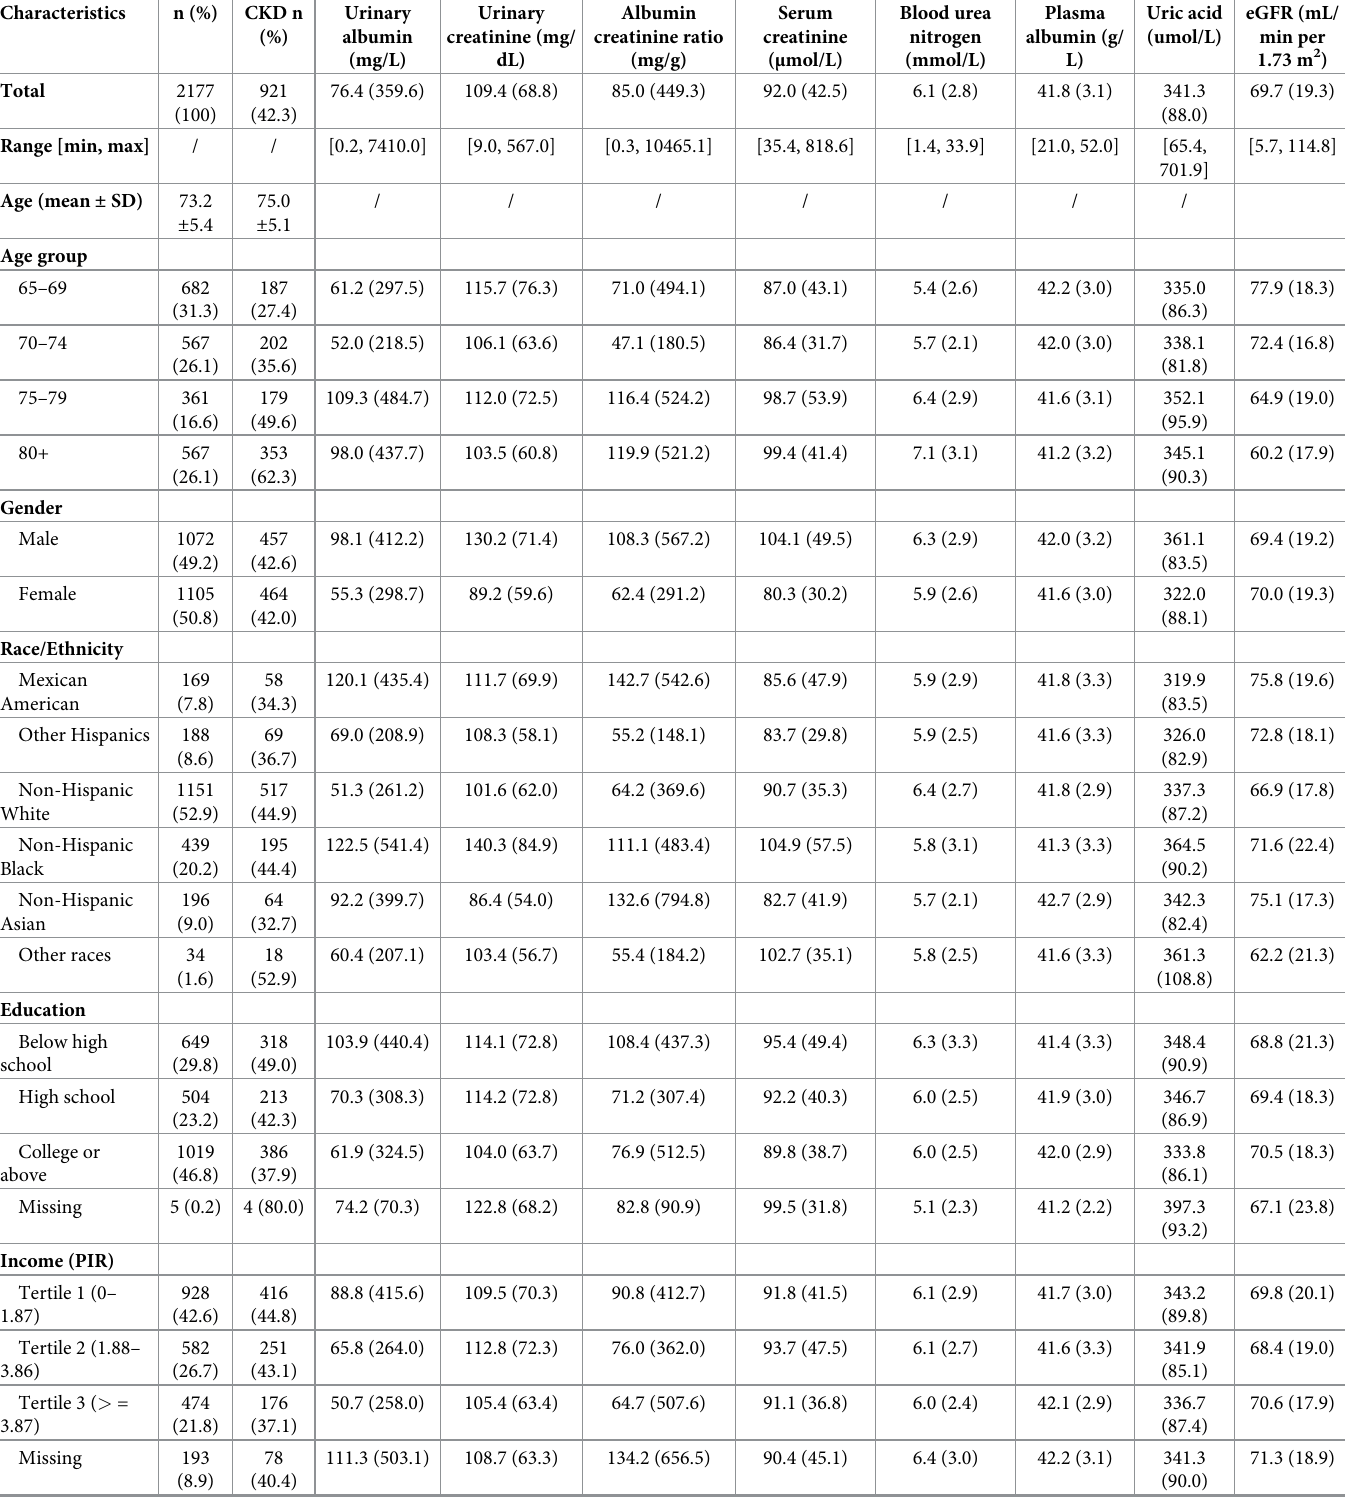
Table 2. Demographic characteristics and mean (SD) of biomarkers (US participants: NHANES 2011–2014).